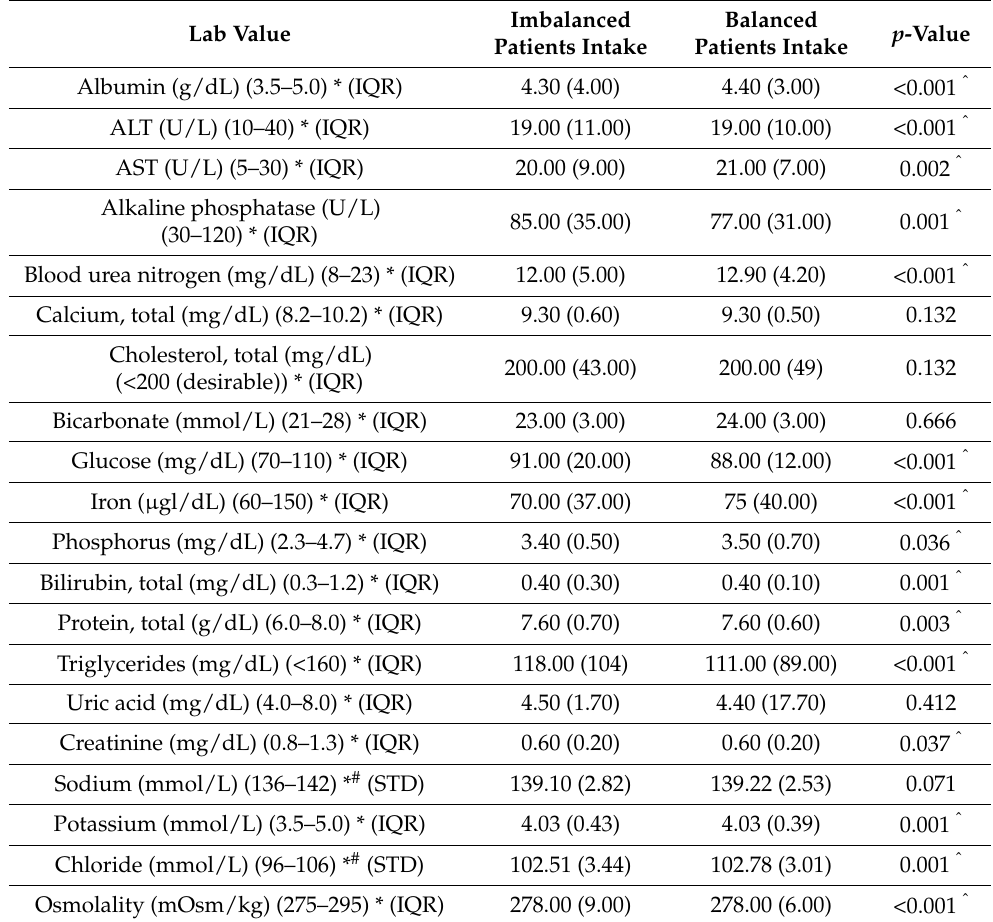
Table 2. Comparison of median and mean (#) laboratory values between Imbalanced and Bal- anced groups.